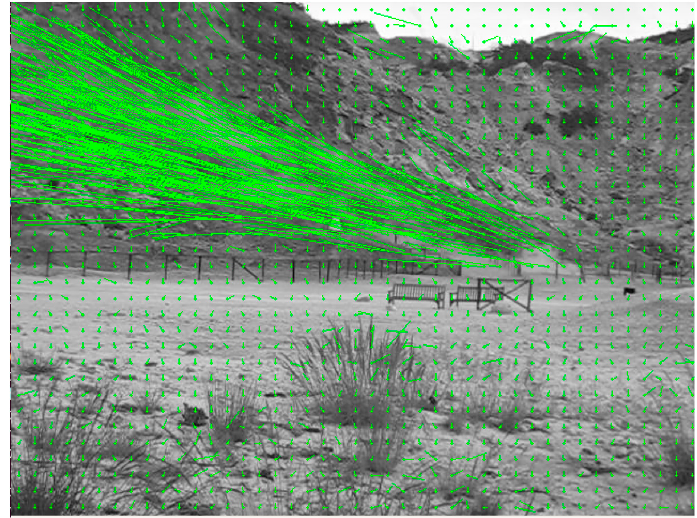
Figure 6. Optical flow vector field with cumulative displacements of all 32 s of video projected onto the last video frame.